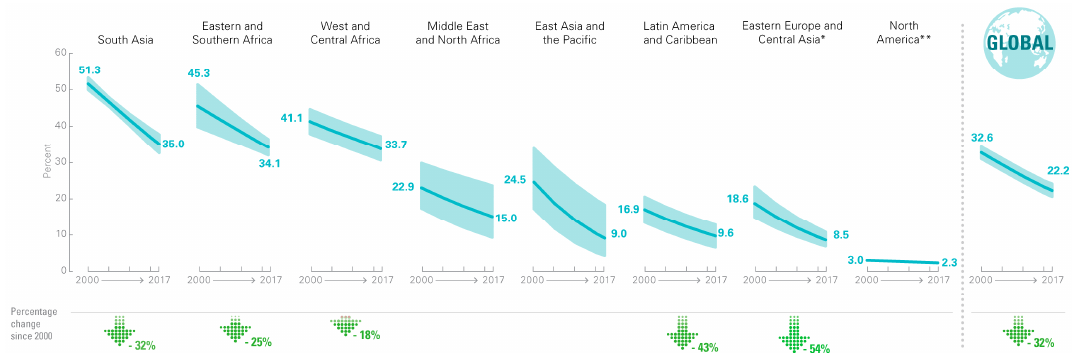
Figure 1. Percentage of children under 5 who are stunted, by region, 2000 to 2017 [6] .